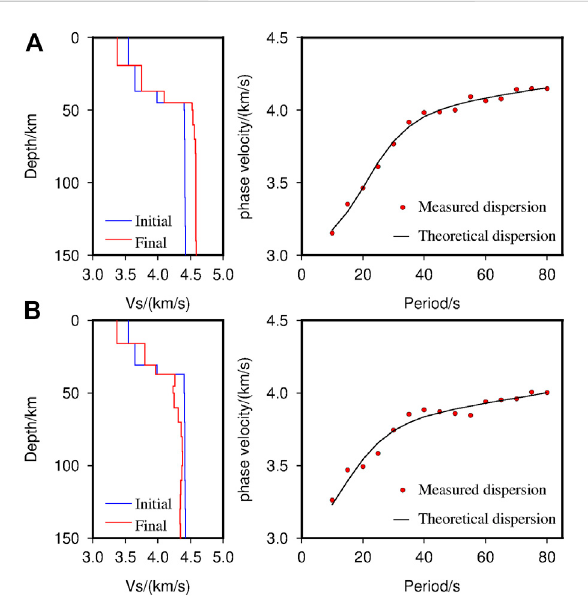
FIGURE 7 1-D velocity structure inversion results of two grids (A) (113.0 ° E, 43.0 ° N)and (B) (115.5 ° E,44.5 ° N)inthestudyarea.Theleft fi guresshow theinitial velocity model (blue) and the fi nalinversionmodel (red).The right fi gures show the measured discrete dispersion points (red dots) and the theoretical dispersion curves calculated by the fi nal